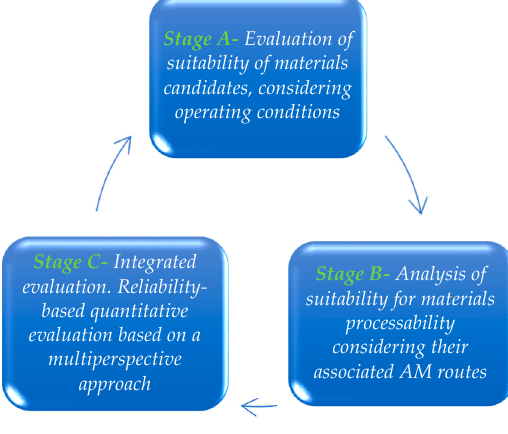
Figure 1. Methodology of analysis.